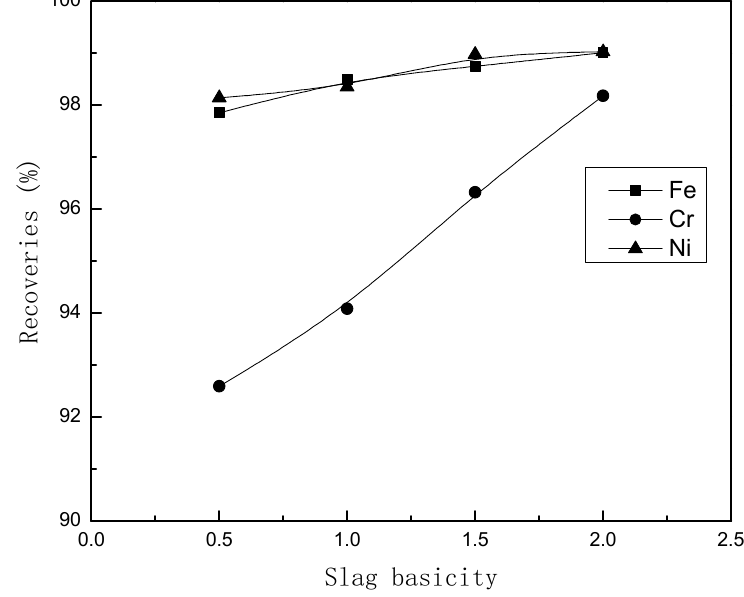
Figure 3. Effect of slag basicity on metals recoveries.